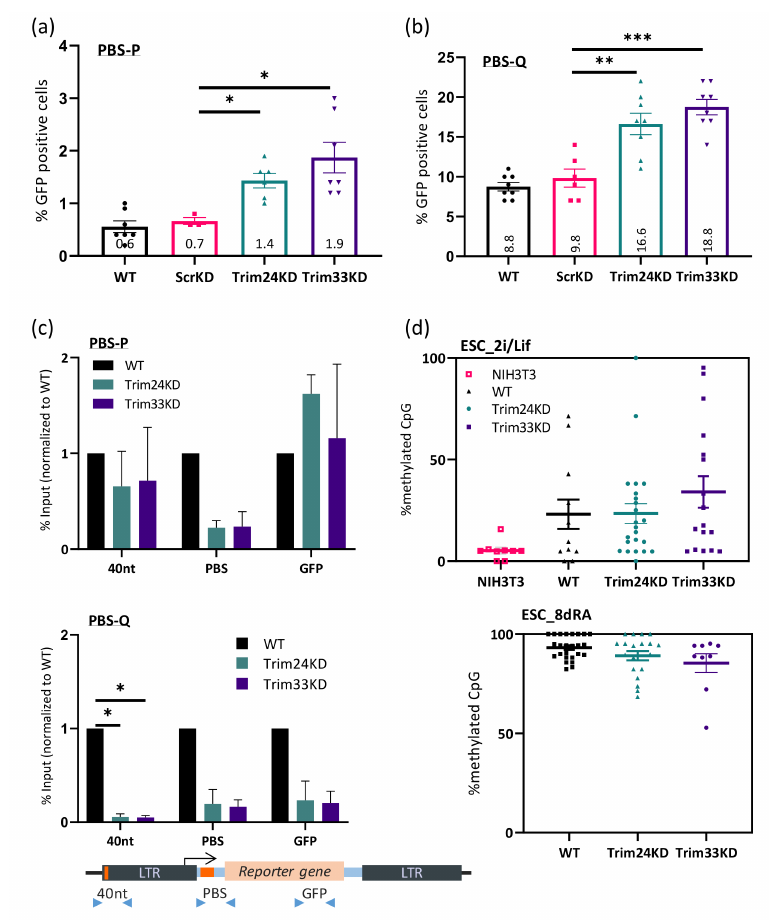
Figure 4. An increase in expression and a decrease in epigenetic silencing of pro-viral sequences following Trim24 or Trim33 depletion. Flow analysis of ESCs expressing shRNA targeting either Scr, Trim24, Trim33 or none, infected by exogenous murine leukemia virus (MLV) vector containing a GFP reporter, with either PBS-P ( a ) or PBS-Q ( b ). The percentage of cells expressing the GFP reporter was measured and normalized to the expression levels in NIH3T3 cells (see Figure S4). Statistics analysis by two-tailed Student’s t-test; * = p < 0.05; ** = p < 0.01; *** = p < 0.001; n > 5. ( c ) ChIP followed by RT-qPCR using H3K9me3 antibody and primers for pro-viral sequences. The ChIP was done separately on cells infected by either PBS-P (top) or PBS-Q (bottom). The location of primers on the proviral genome is illustrated in the diagram below. See Figure S3 for ChIP controls, statistical analysis was performed by two-tailed student t-test; * = p < 0.05; n = 2. ( d ) Bisulfite sequencing analysis of the 5 (cid:48) LTR–the 40nt region-of the infecting virus was performed on WT, Trim24 KD and Trim33 KD ESC and NIH3T3 di ff erentiated cells as control; ESC was next di ff erentiated by 8 days RA induction